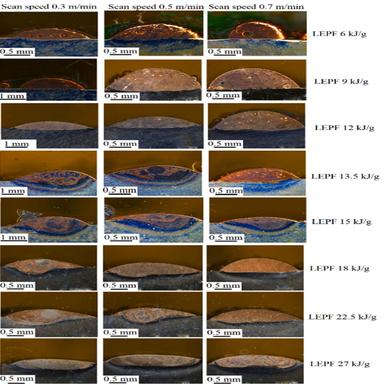
Transverse section of track deposited at different LEPF and scan speed.